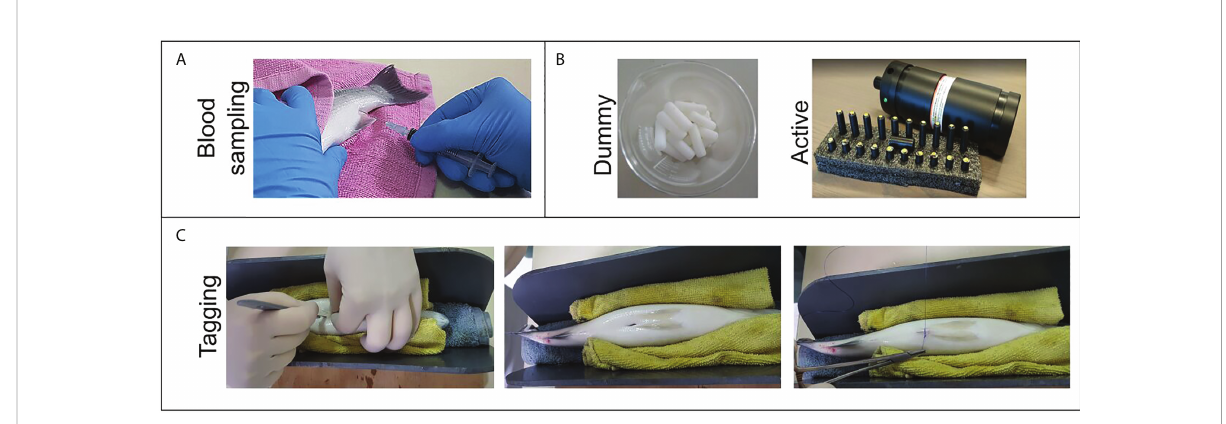
FIGURE 2 Explanatory photographic material about the experimental procedure. (A) Blood sampling, (B) Dummy and active tags used for the experiment, (C) Intracelomic implantation of the